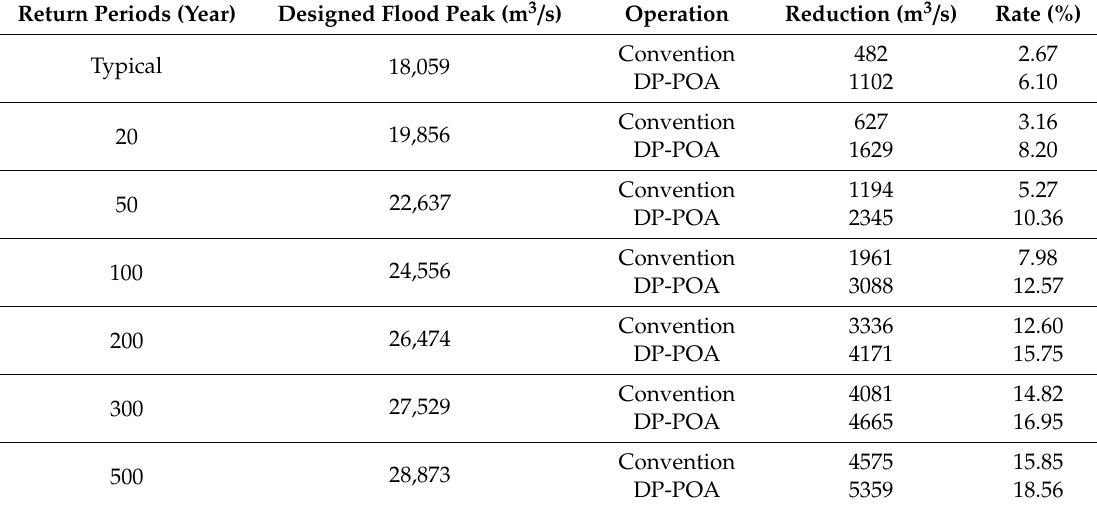
Table 8. Flood peak at the Shishang flood control point.